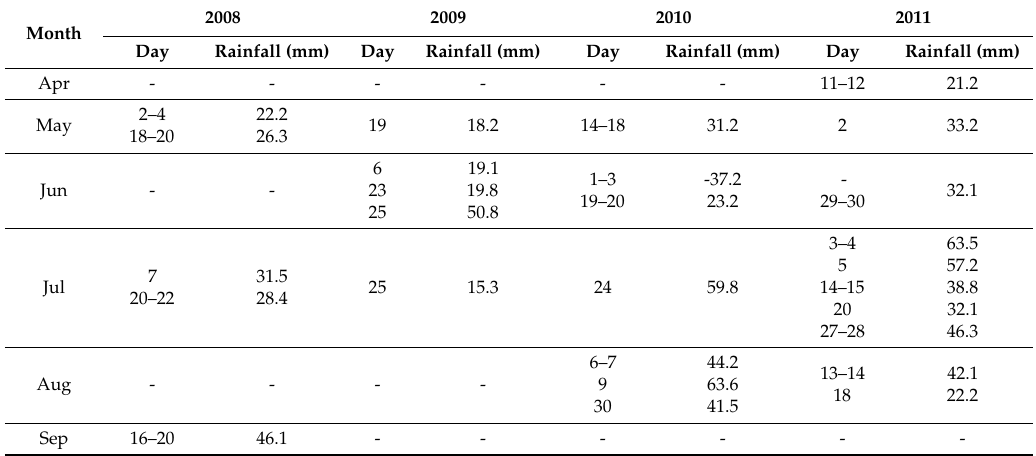
Table 1. Date of occurrence and amount of erosive